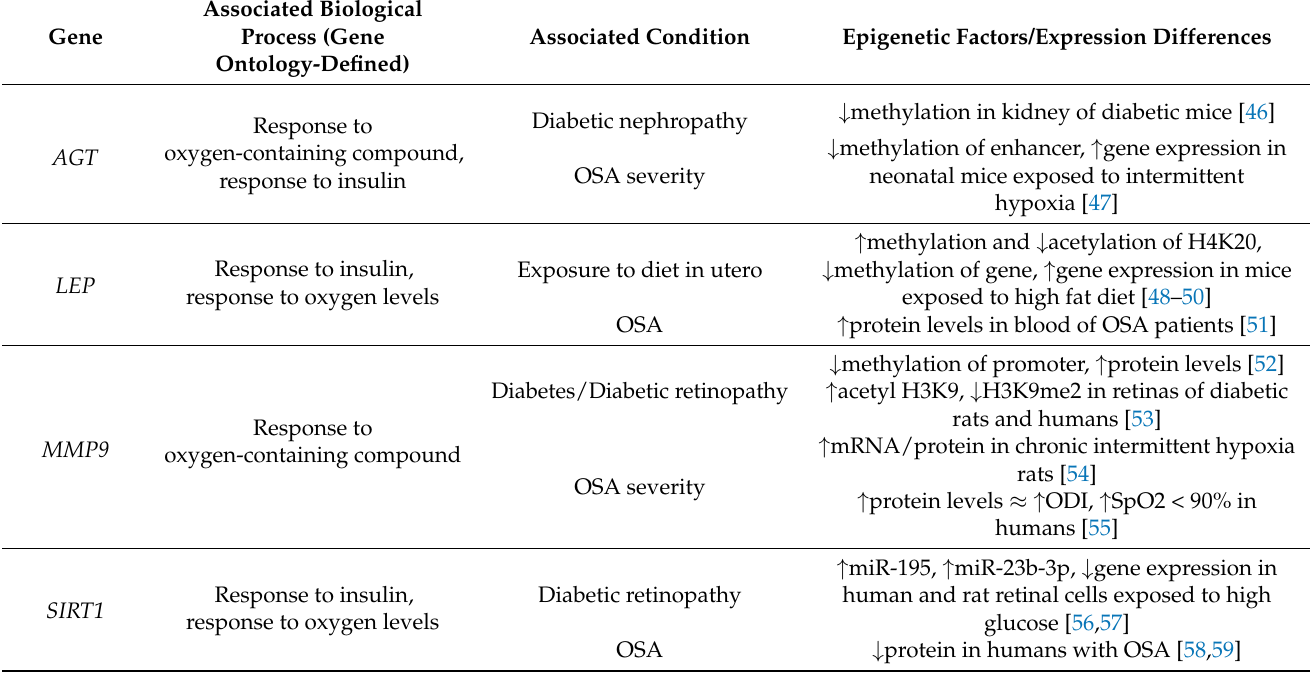
Table 1. Evidence of epigenetic modifications connecting OSA and